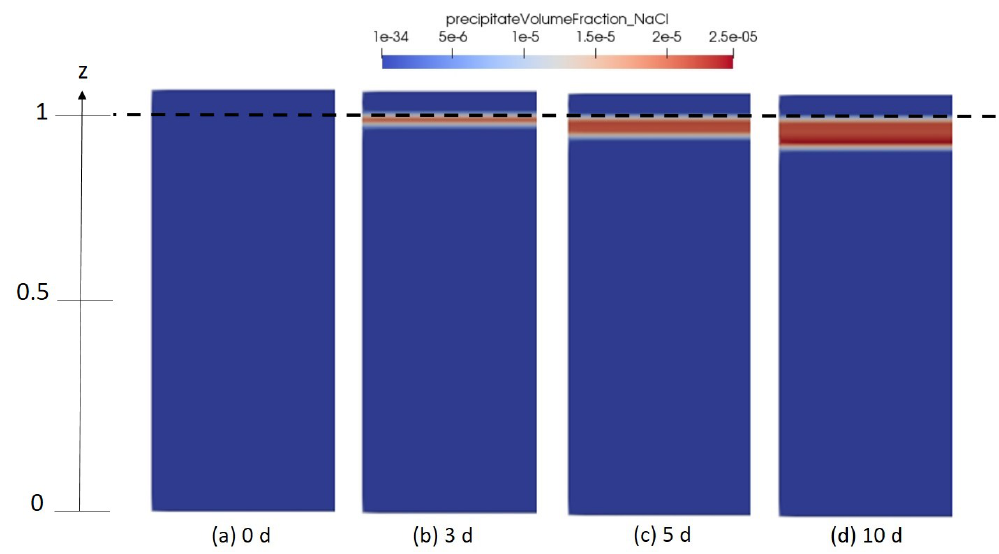
Figure 12. Numerical results depicting the spatial distribution of halite solidity in the porous medium